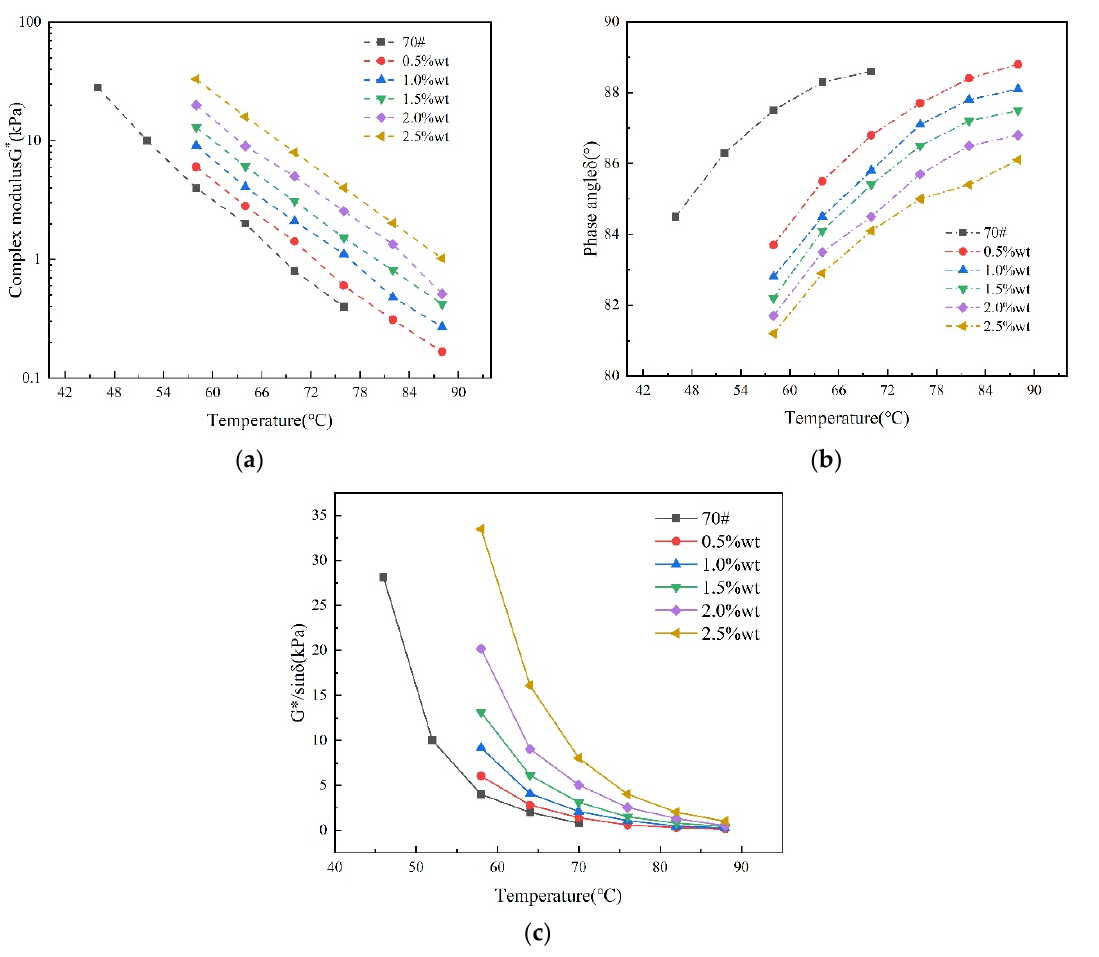
Figure 6. Temperature frequency ‐ sweep response curves of MWCNTs ‐ MA: ( a ) Complex modulus; ( b ) Phase angle; ( c ) Rutting factors.